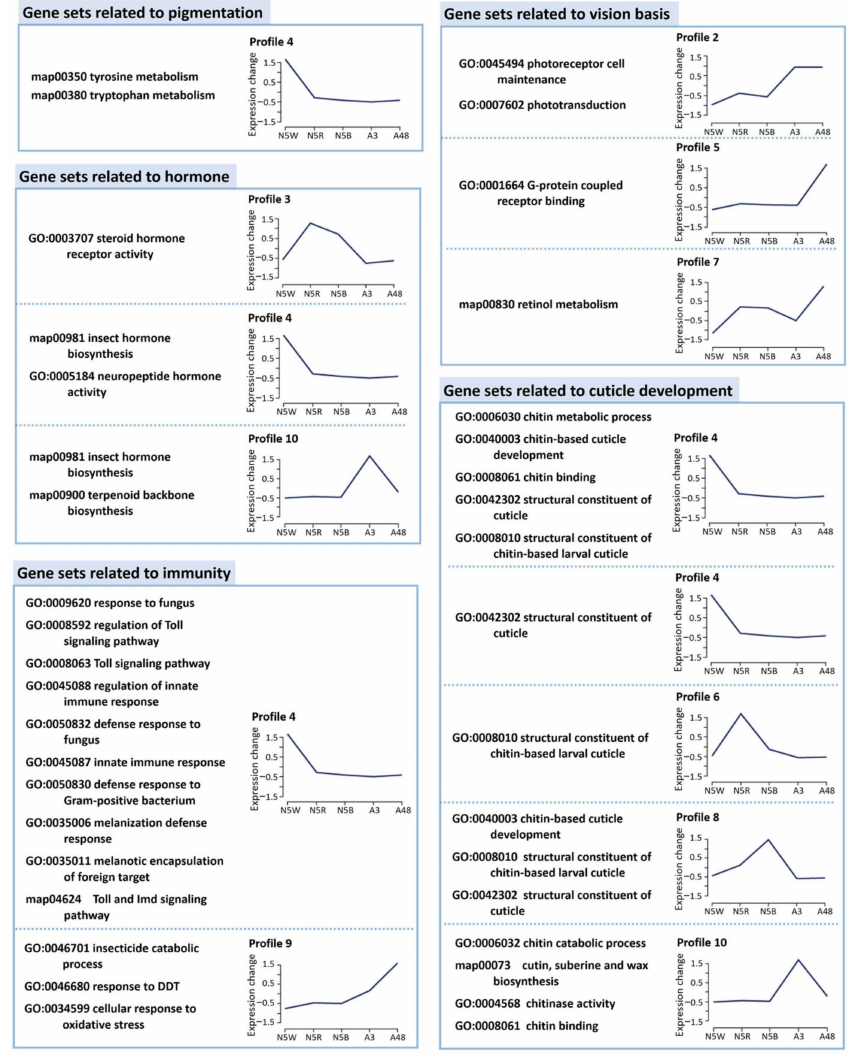
Figure 2. Functional enrichment analysis of profile-specific DEGs (GO terms and KEGG pathways). GO function and KEGG pathway enrichment analyses were performed on DEGs in the 10 profiles, respectively. The significantly-enriched gene sets ( p -value < 0.01, Enrichment Fold > 5) were focused and analyzed, which are related to specific biological functions including coloration, phototransduc- tion, hormonal regulation, innate immune response and cuticle development,